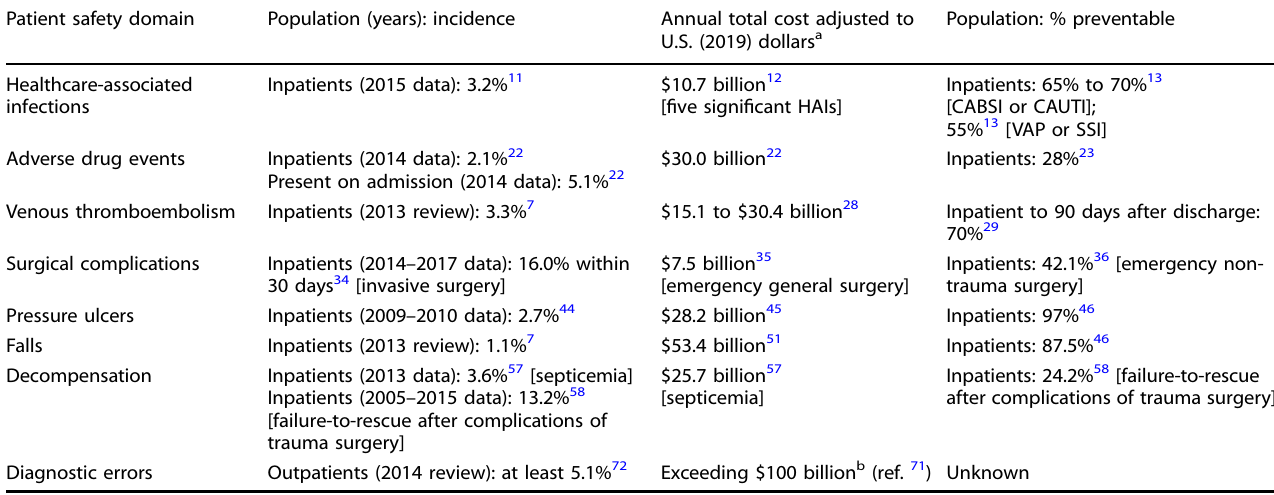
Table 1. Incidence, cost, and preventability of events in the eight harm domains from the peer-reviewed literature. Patient safety domain Population (years):